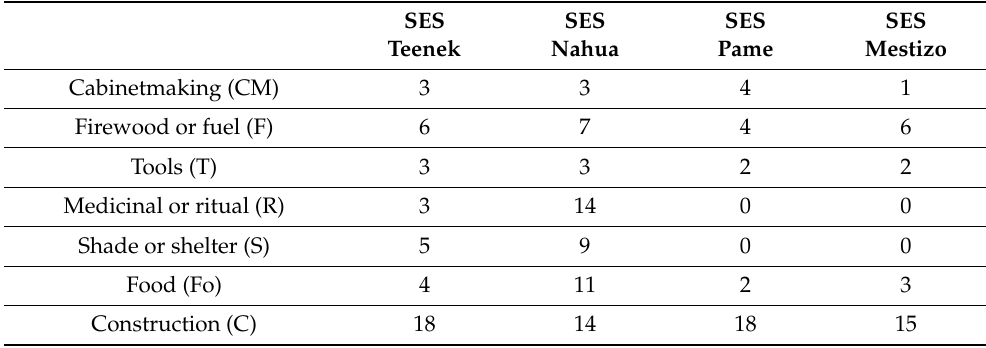
Table 2. Number of species for each use by SES of Huasteca